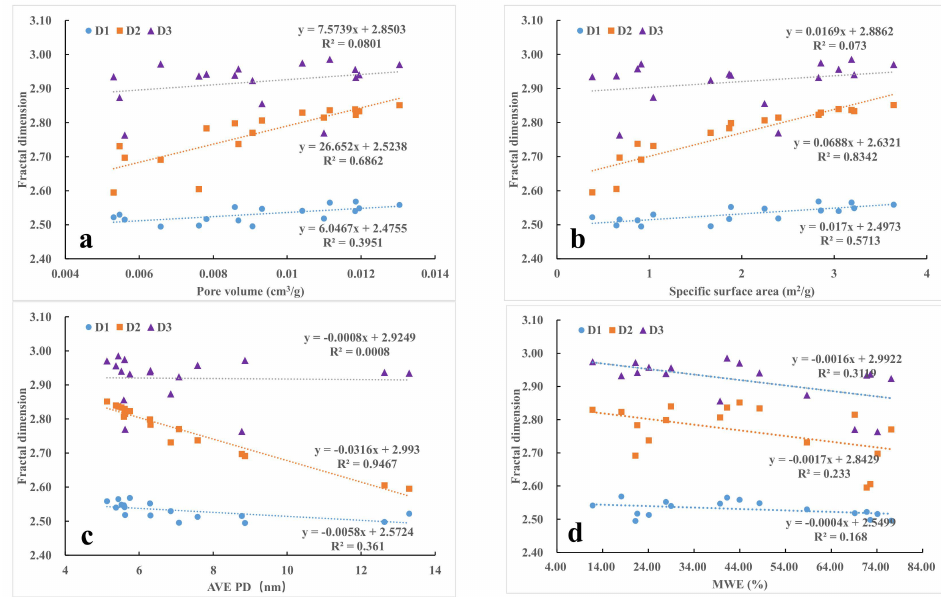
Figure 9. Relationship between fractal dimension and pore structure parameters: ( a ) relationship be- tween fractal dimension and PV; ( b ) relationship between fractal dimension and SSA; ( c ) relationship between fractal dimension and AVE PD; ( d ) relationship between fractal dimension and